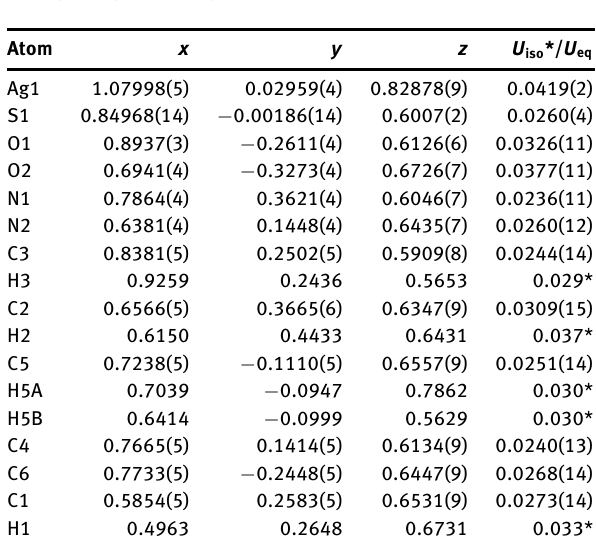
Table 2: Fractional atomic coordinates and isotropic or equivalent isotropic displacement parameters (Å 2